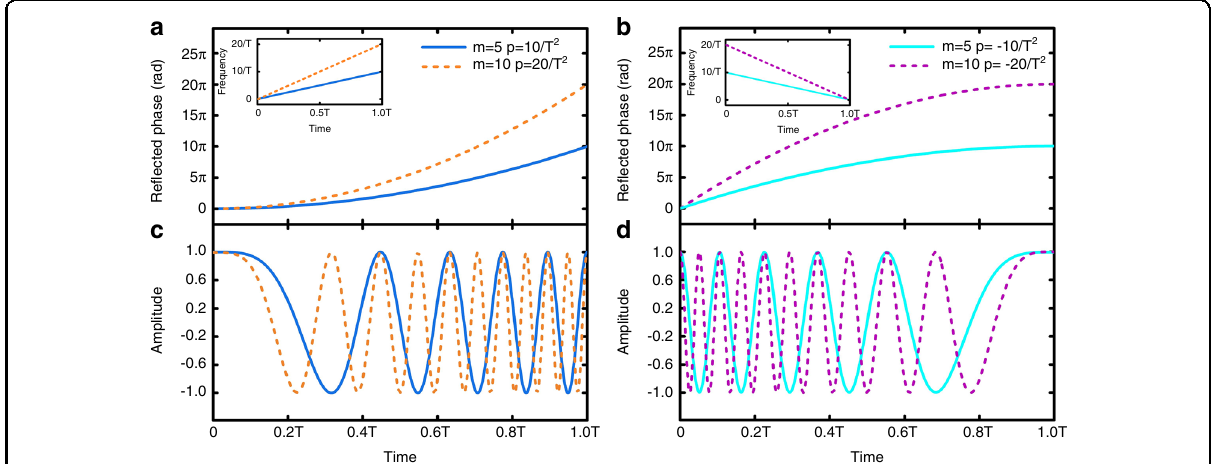
Fig. 2 Generations of linear FMCW signals based on STCM with nonlinear periodic phases. a , b Four types of re fl ection phase responses φ 0 t ð Þ under different combinations of the frequency slope p and the repetition number m , in which the insets show the corresponding time-frequency diagrams after down-conversions. c , d The linear FMCW waveforms of the four cases in